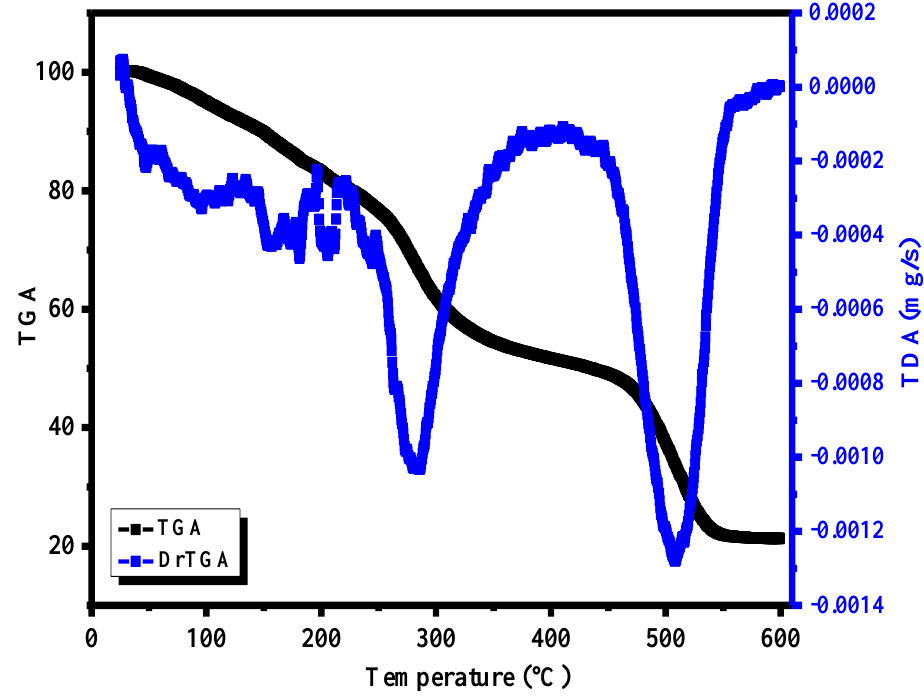
Figure 6. TDA and TGA graph for Yb 2 O 3 /V 2 O 5 /GO@CS.